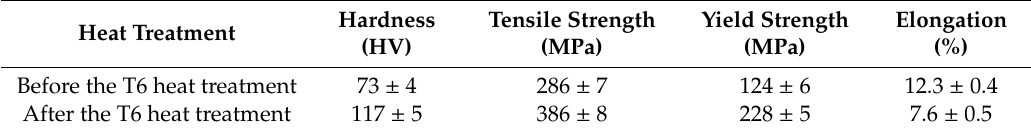
Table 3. Mechanical properties of scrolls before and after the T6 heat treatment.